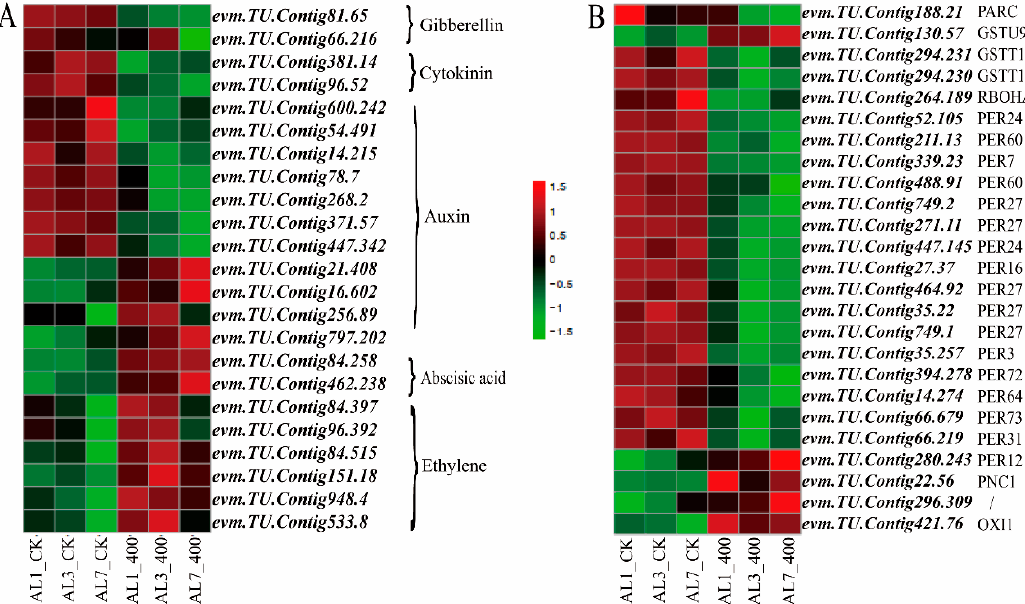
Figure 11. Aluminum stress induces the expression of ROS and hormone-related genes. The threshold of FDR < 0.05, |log2 (FoldChange)| > 1 was used to screen DEGs between the treated group and the control group after aluminum stress at different times. ( A ) Heat map of hormone-related gene expression. ( B ) Heat map of ROS-related gene